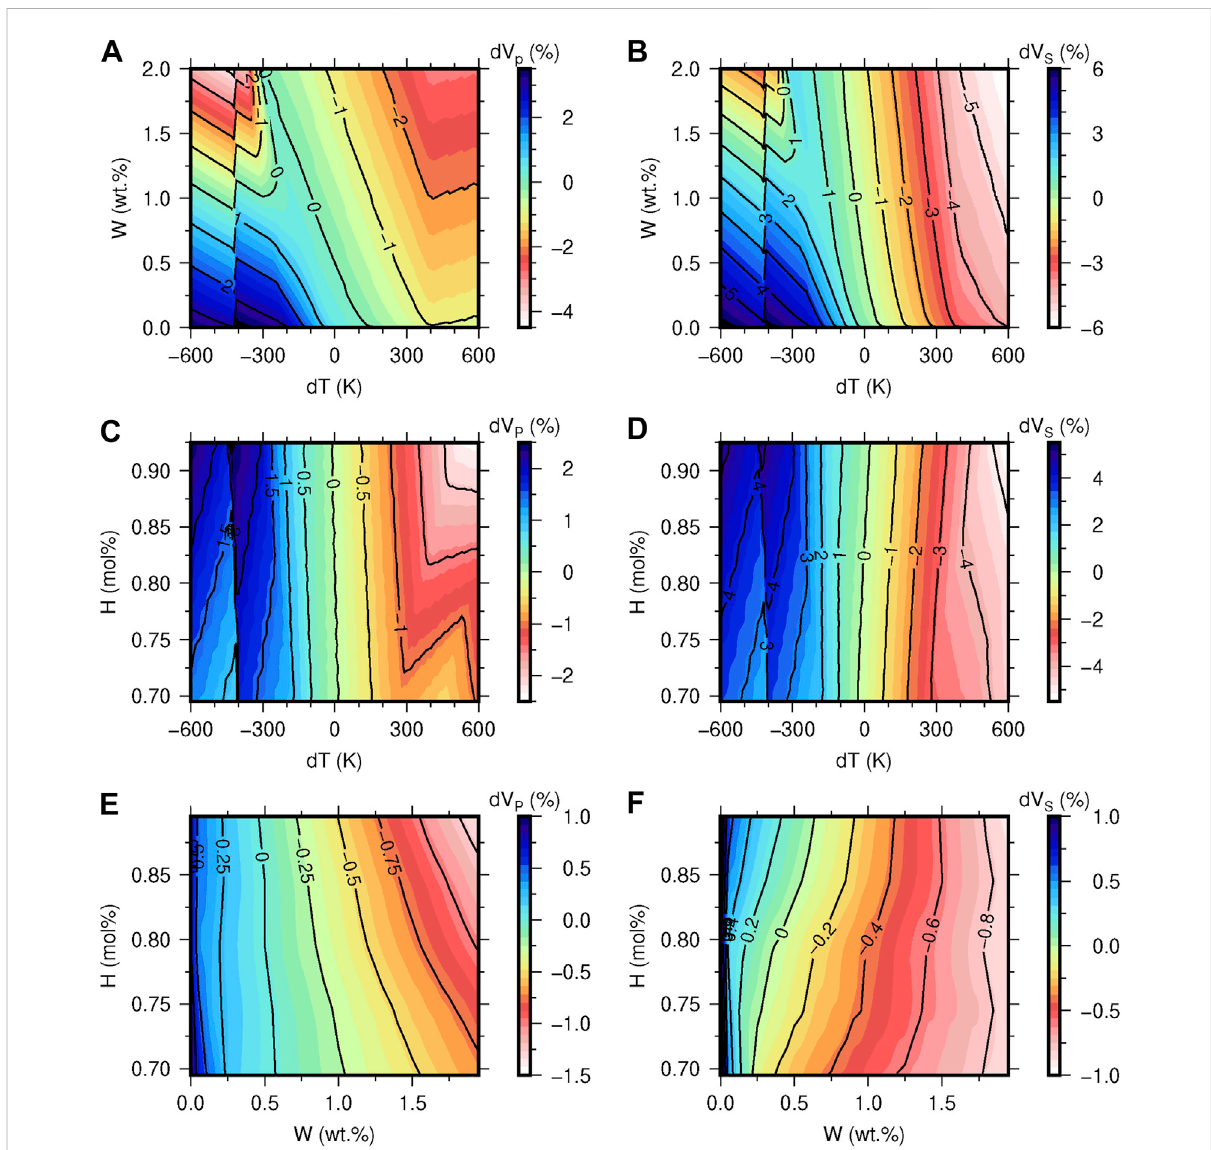
FIGURE 2 The sensitivity kernels of P- and S-wave velocity anomalies in the upper MTZ to water and temperature based on the pyrolite composition model (A,B) ; to temperature and harzburgite abundance based on a water content of 0.5 wt% in wadsleyite (C,D) ; to water and harzburgite abundance based on the 1,400 ° C adiabatic geotherm (E,F)